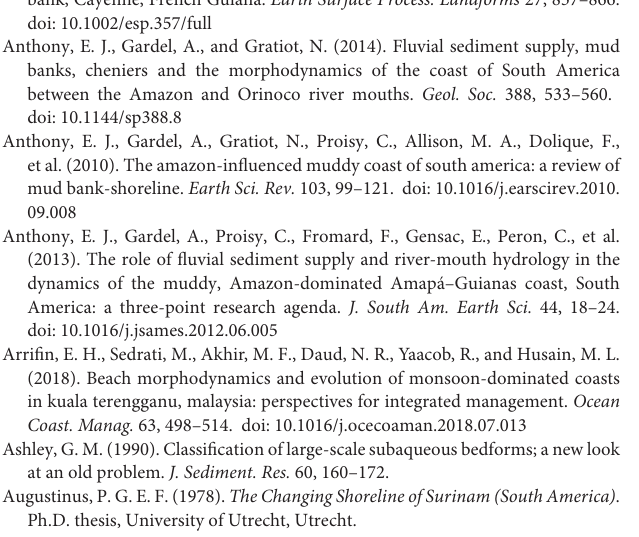
TABLE S1 | Inventory of aerial photographs and satellite images used in the study. TABLE S2 | Summary of items concerned by the four photogrammetric